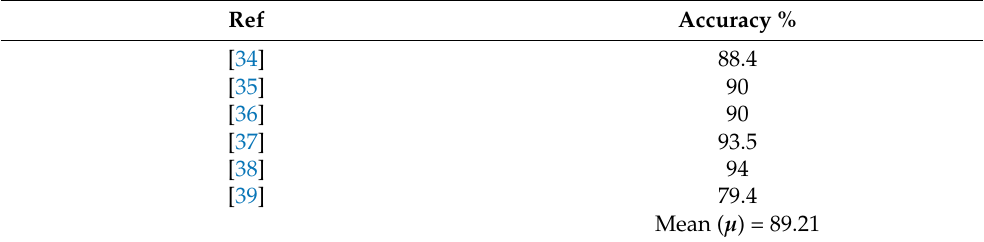
Table 1. Mean accuracy of the reviewed preliminary EMG